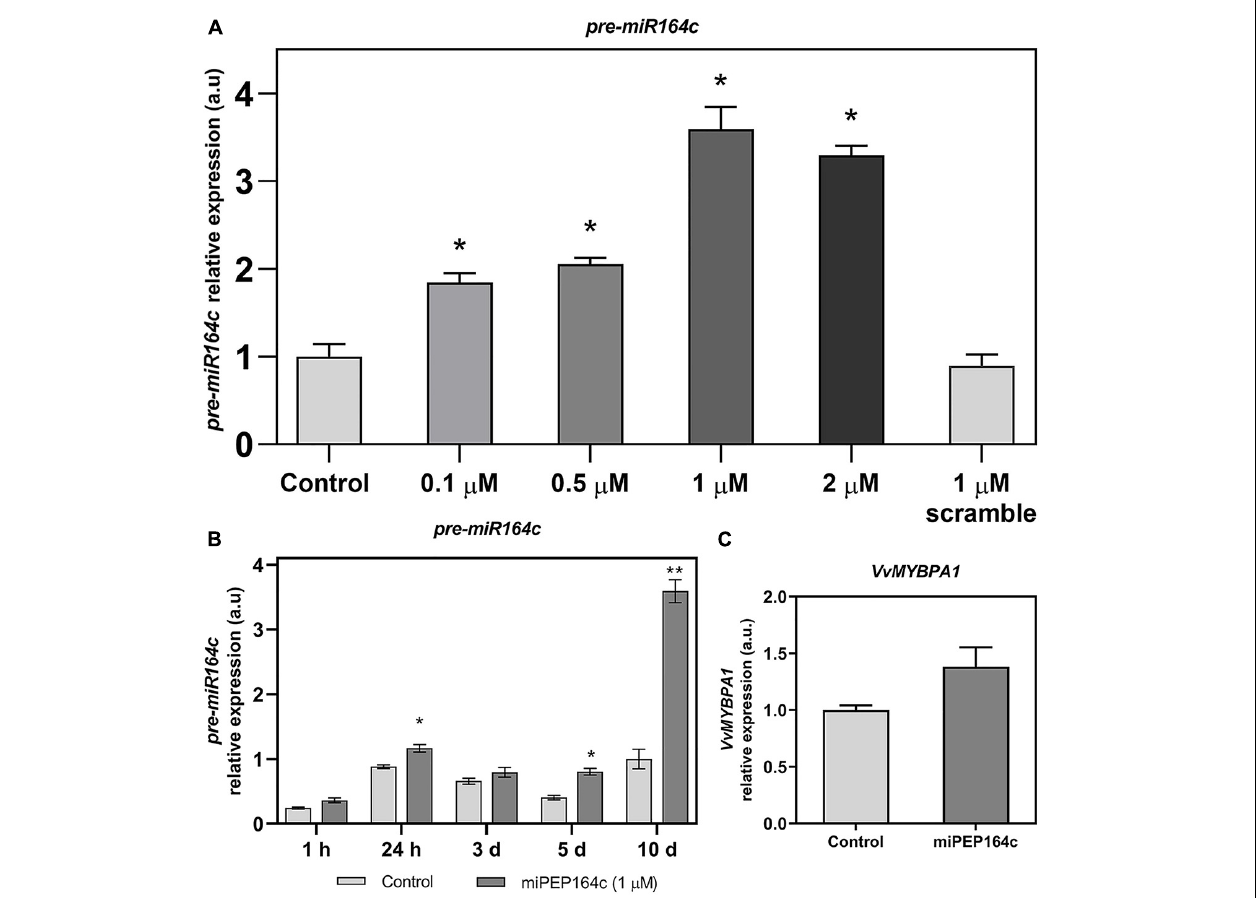
FIGURE 1 | Steady-state transcript levels of pre-miR164c in suspension-cultured grape berry cells (cv. Gamay) 10-day after elicitation with various concentrations of miPEP164c (A) in suspension-cultured grape berry cells (cv. Gamay) eliciated with 1 µ M of miPEP164c throughout a period of 10-day (B) and the steady-state transcript levels of VvMYBPA1 (C) in suspension-cultured grape berry cells (cv. Gamay) 10 days after elicitation with 1 µ M miPEP164c. Gene expression analysis, by real-time qPCR was normalized with the expression of reference gene VvACT1 and VvGAPDH . Values are the mean ± SEM. Asterisks indicate statistical significance in relation to the control (Student’s t -test; * P < 0.05; ** P < 0.001).